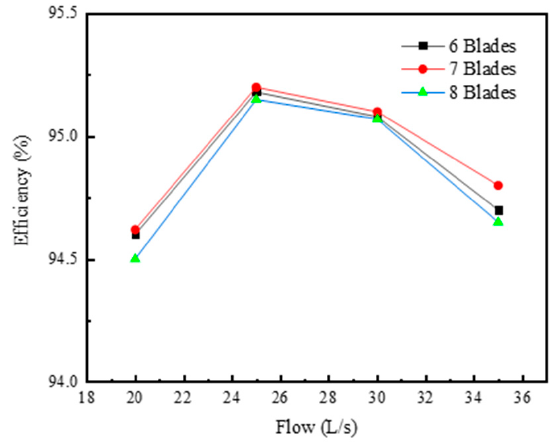
Figure 15. Turbine efficiency corresponding to different number of blades.